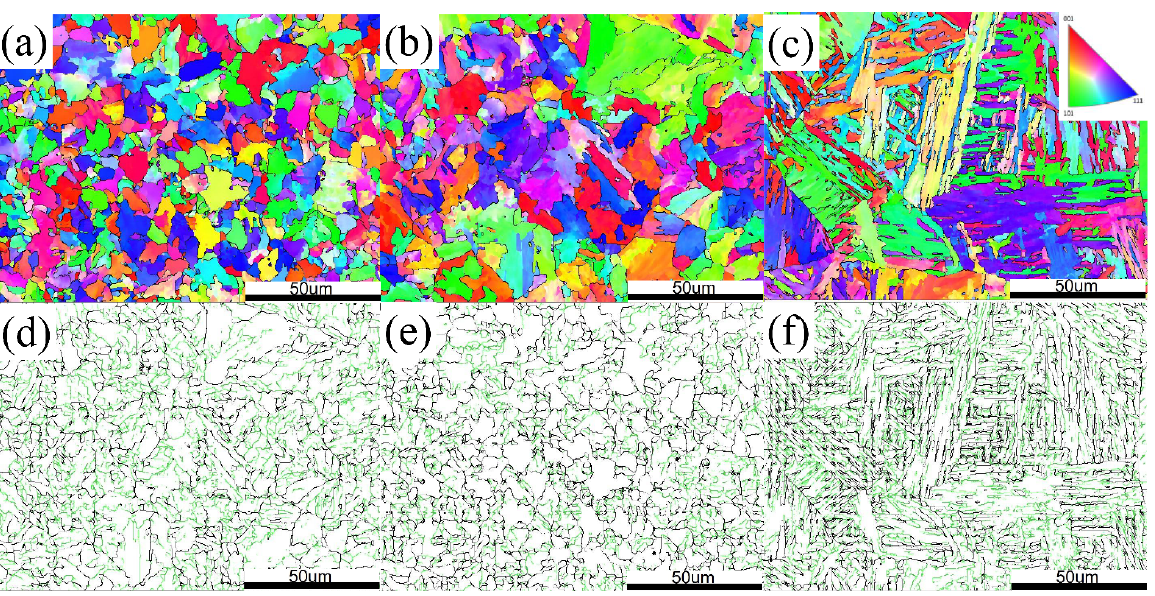
Figure 8. Grain orientation image maps ( a – c ) and grain boundary misorientation distribution ( d – f ): ( a , d ) S1, ( b , e ) S2, and ( c , f ) S3.